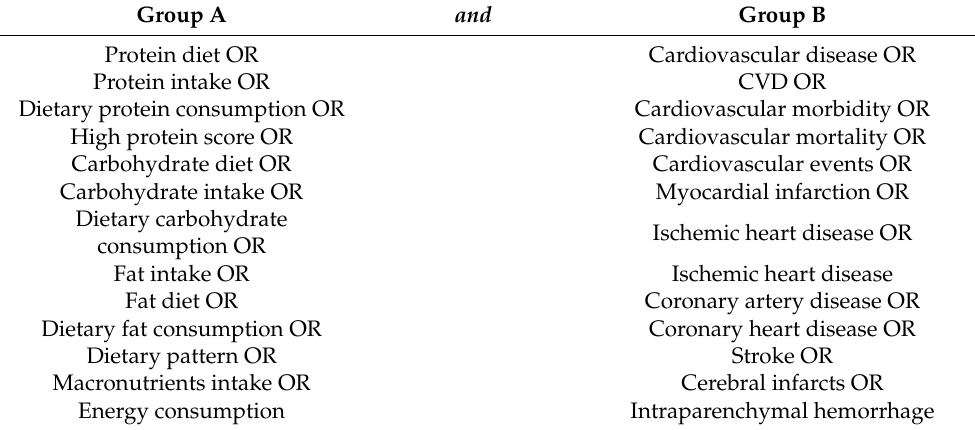
Table 1. Full search strategy. Group A